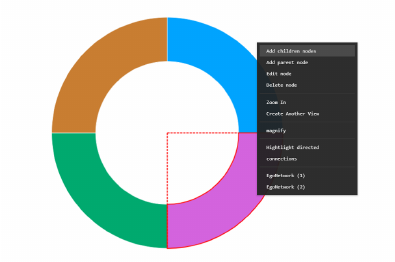
Figure 19. Interactive creation of the hierarchical structure of the course contents through contex- tual menus.